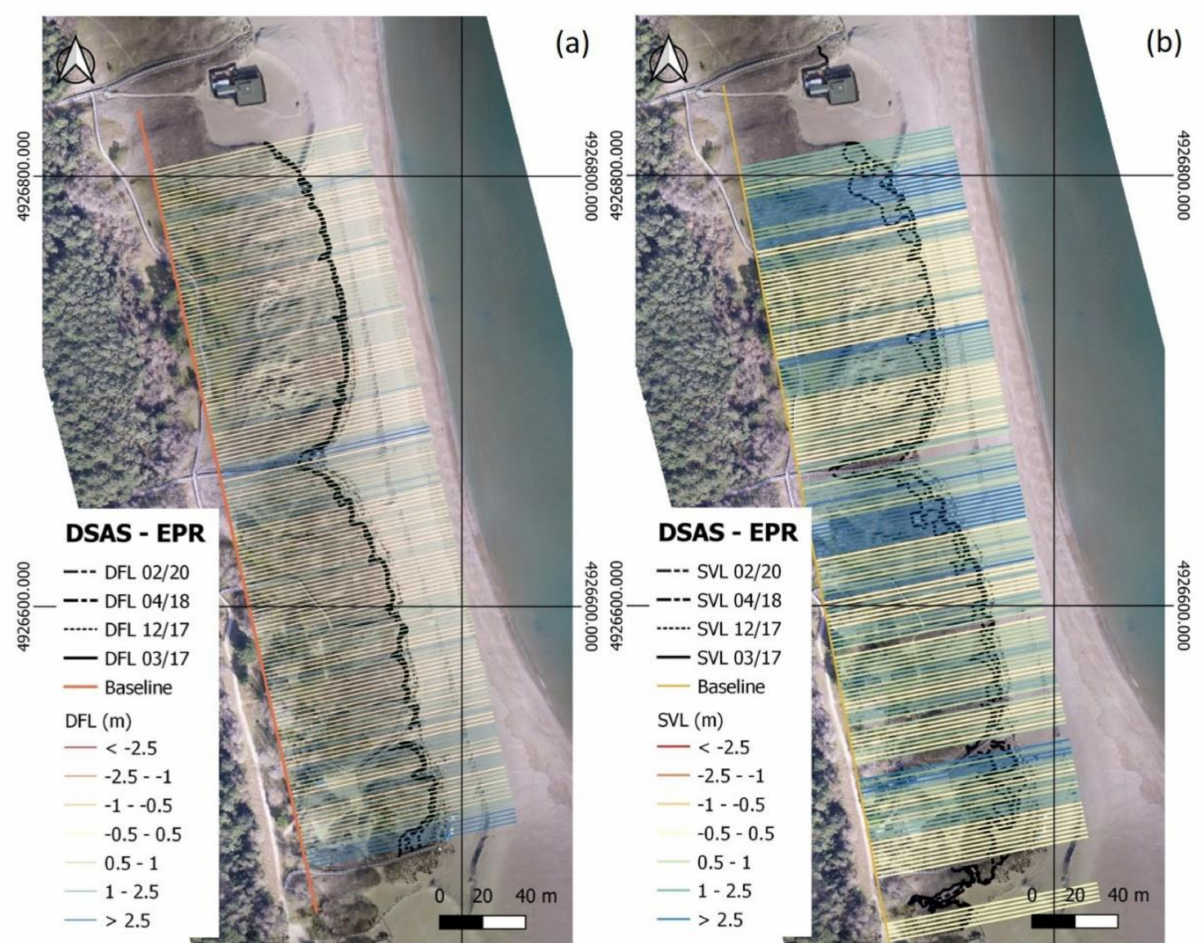
Figure 8. EPR results from DSAS analysis: ( a ) the dune foot line; ( b ) the stable vegetation